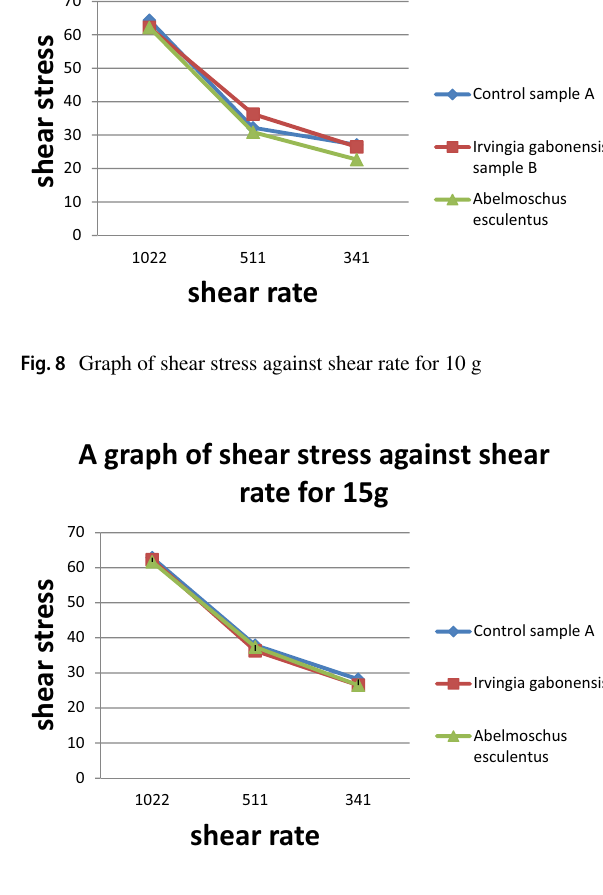
Fig. 9 Graph of shear stress against shear rate for 15